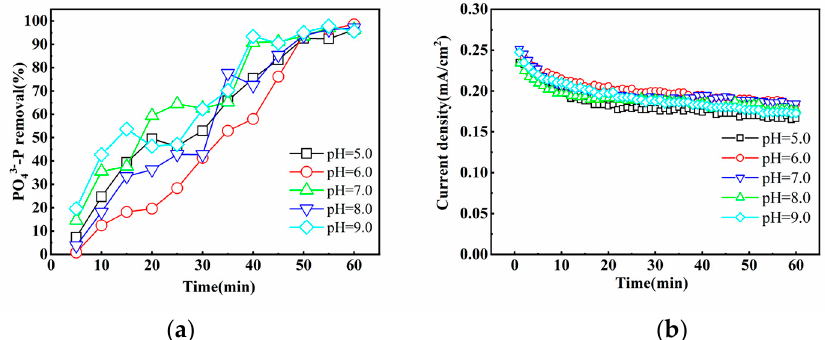
Figure 4. Effects of different initial pH values on ( a ) phosphate removal and ( b ) current generation in the aluminum − air fuel cell.